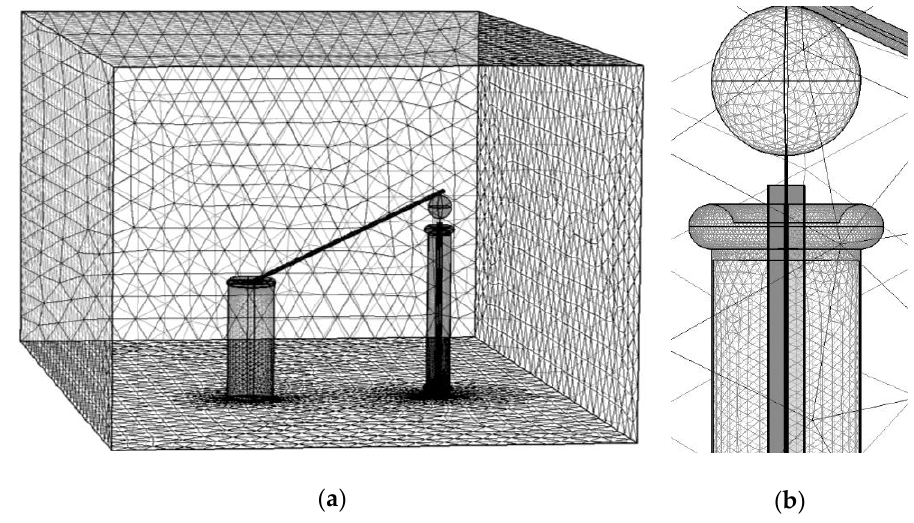
Figure 11 . Vertical grading cylinder (aluminum, R = 0.1 m) with a top corona protection toroid to minimize the effects of the stray capacitance. ( a ) Mesh of the full layout, including the high-voltage source, the divider, and the grading cylinder, ( b ) Detail of the aluminum grading cylinder.